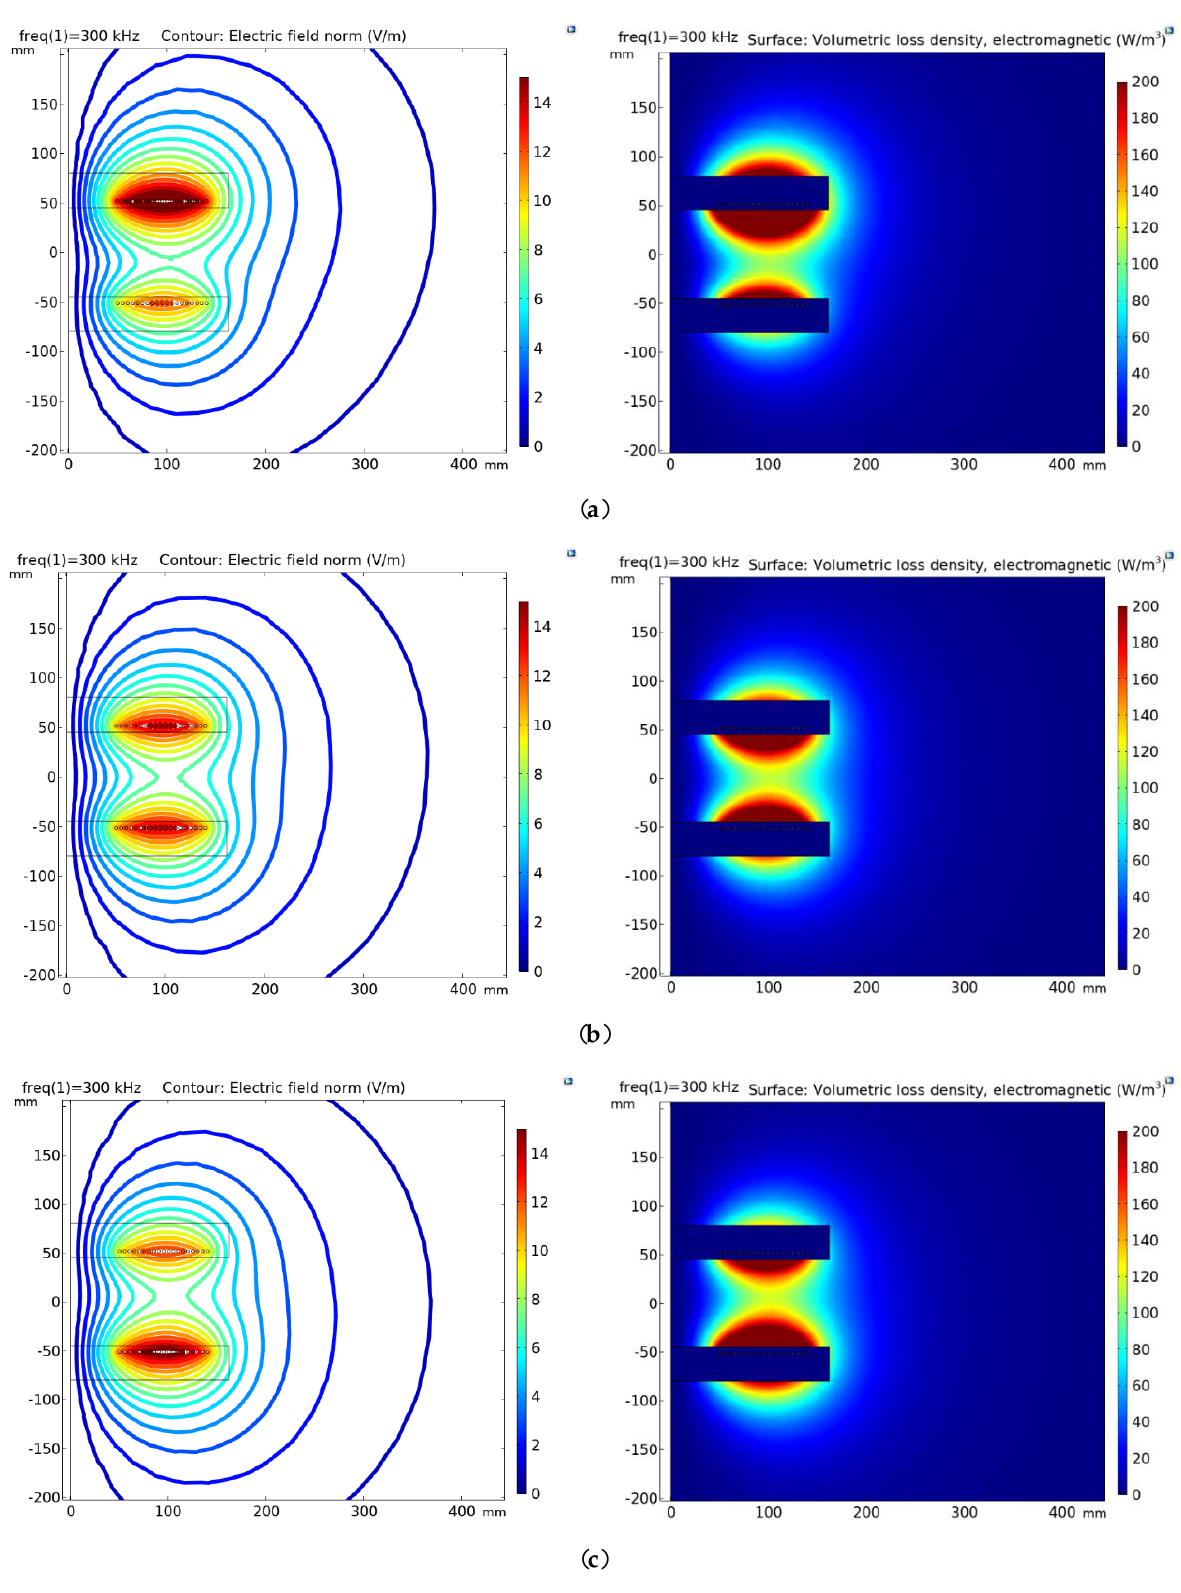
Figure 13. Electric field intensity, energy loss density, and AC-AC efficiency under different modulus ratios when f = 300 kHz, α 0 = 1.1103. ( a ) α/α 0 = 0.65, η = 0.7563; ( b ) α/α 0 = 1.01, η = 0.7832; ( c ) α/α 0 = 1.33, η = 0.8114.